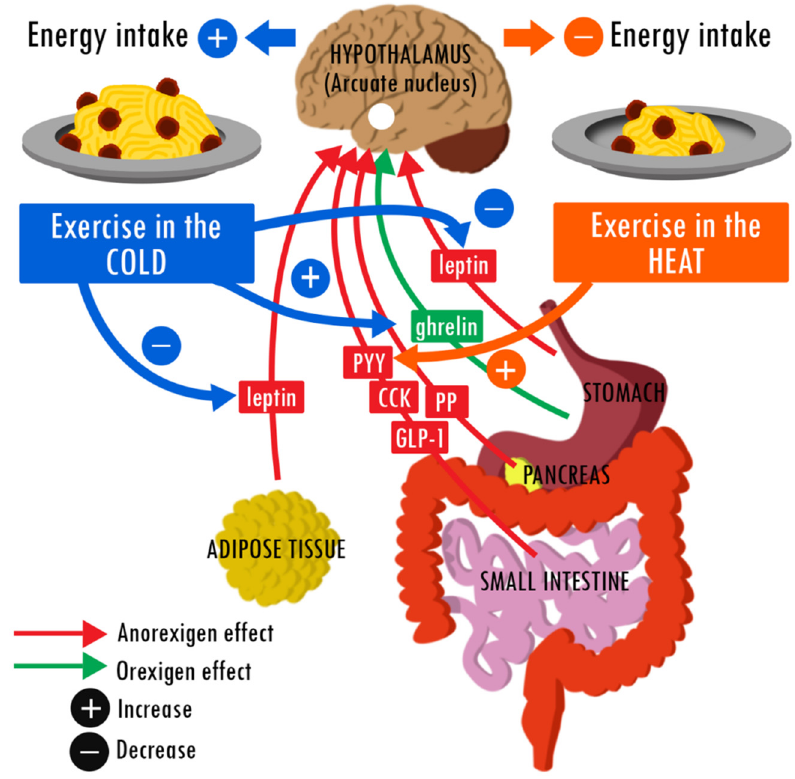
Figure 1. Hypothetical effects of heat and cold during a single exercise session on the regulation of food intake. Literature suggests that exercising under cool conditions induces an increase in post-exercise EI relative to the same exercise under thermoneutral conditions. This orexigenic effect could be explained in part by a decrease in plasma leptin and an increase in acylated ghrelin levels. Exercising in the heat may have an opposite effect, thus decreasing EI relative to exercising at a neutral temperature. The difference potentially involves an increase in plasma PYY levels.